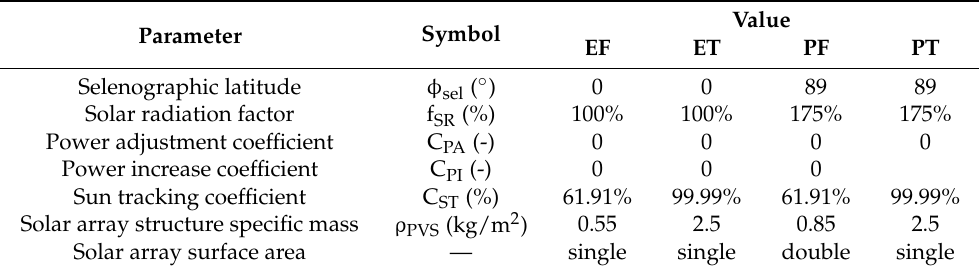
Where: EF—equatorial location with fixed array mount, ET—equatorial location with solar tracker, PF—polar location with fixed array mount, PT—polar location with solar